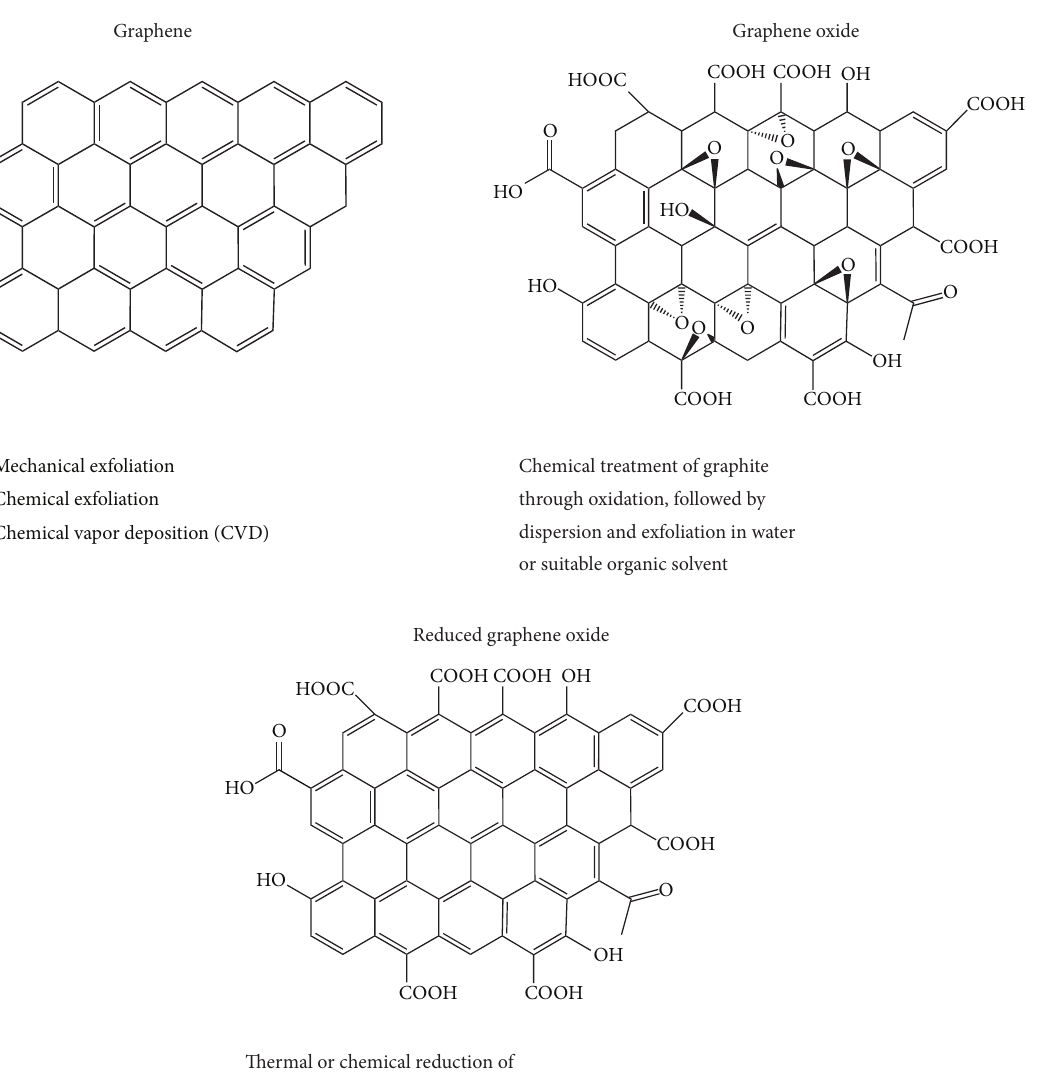
Figure 1: Methods of obtaining graphene and its